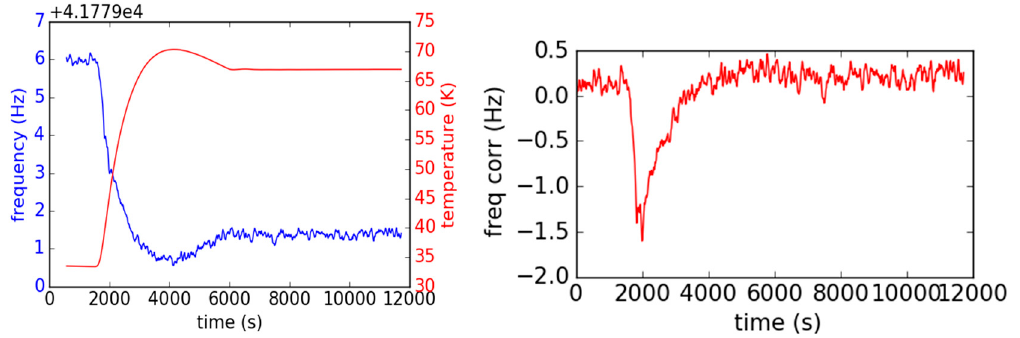
Figure 4. Transient behavior measured on an actual cell and residual frequency shift after polynomial